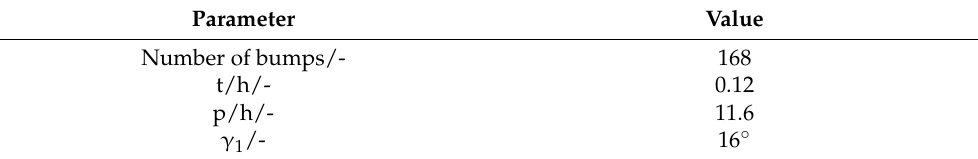
Table 1. Geometrical parameters for wave-shaped bumps inside the flat tube channel.